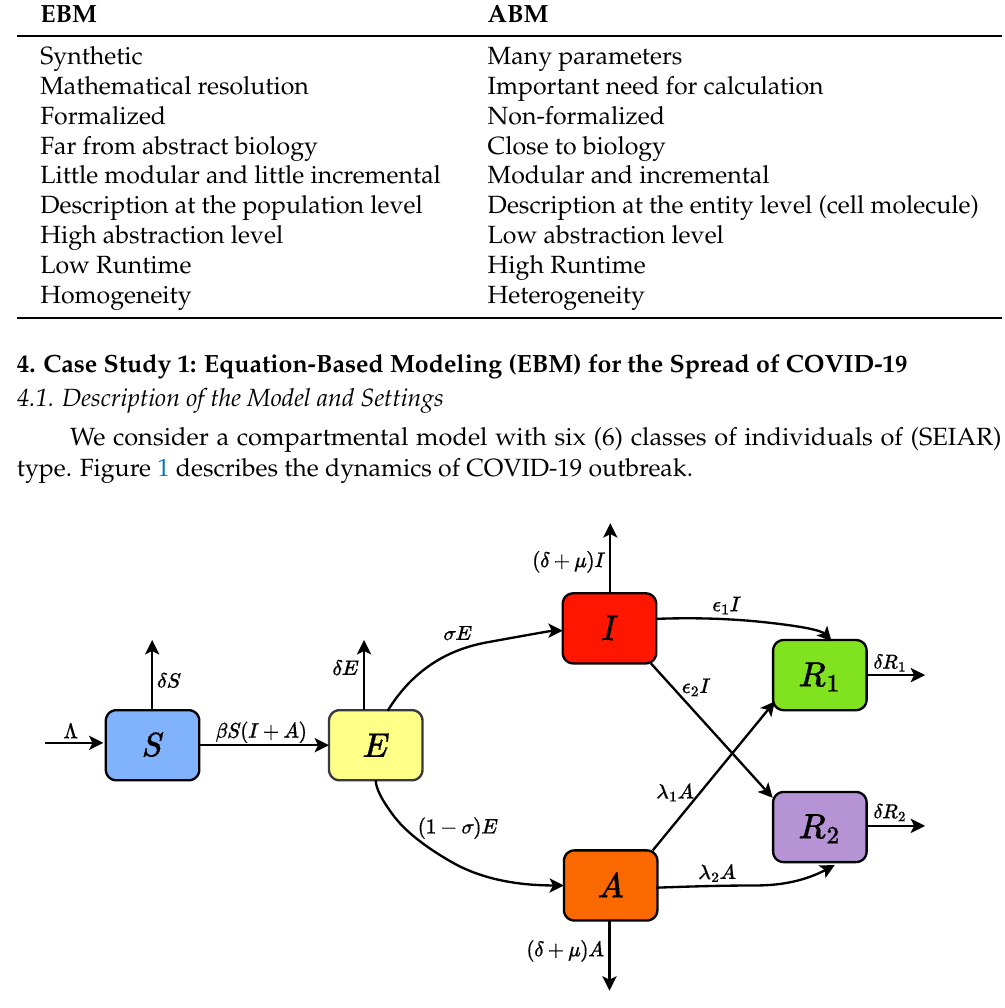
Figure 1. EBM—transfer diagram describing the COVID-19 dynamics in the